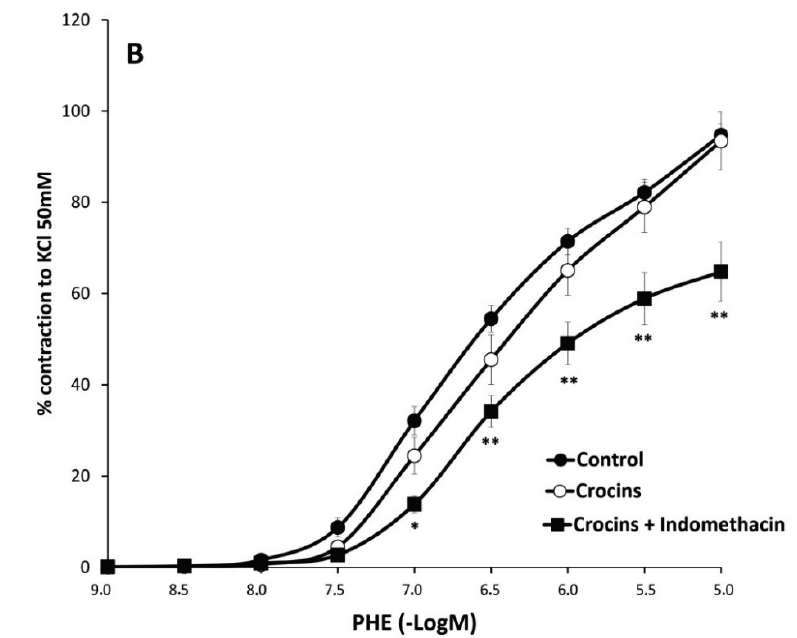
Figure 3. Effects of crocetin (CCT) (panel A ) and crocins (panel B ) on the responses of aortic segments to increasing concentrations of phenylephrine in the presence or absence of indomethacin. Inset figure shows the effects of indomethacin alone on phenylephrine contractions. Inhibition of the cyclooxygenase pathway reduces contractions elicited by phenylephrine. * p < 0.05, ** p < 0.01 compared with the control curve.